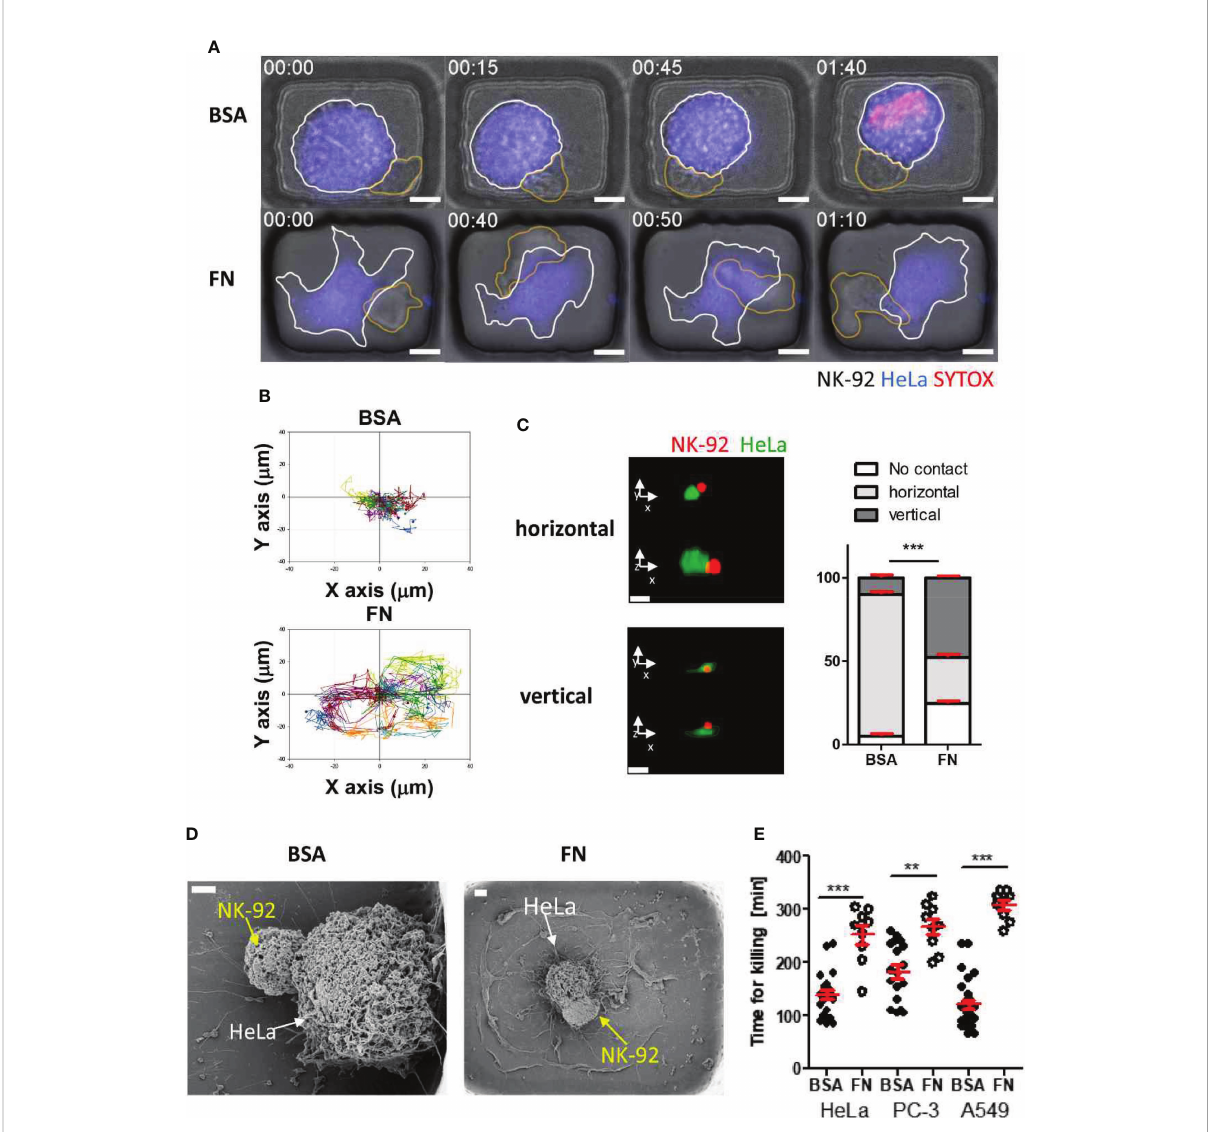
FIGURE 5 Dynamic behaviors and cytotoxicity of NK cells in microwells coated with BSA or FN (A) Representative time-lapse images of NK-HeLa interactions in microwells coated with BSA or FN. Scale bars: 10 m m. (B) Representative trajectories of NK cell centroid. For each case, 15 NK cells were traced over 5 h and plotted with the initial NK-tumor contact points as the origin. (C) Representative confocal images of NK-92 (red) HeLa (green) pairs in microwells and their distributions in BSA- and FN-coated microwells. Scale bars: 15 m m. (D) Representative SEM images of NK-92-HeLa pairs in BSA- and FN-coated microwells. Scale bar: 2 m m. (E) Effects of microwell surface coating on time for killing. Mann- Whitney test was used, ** < 0.01, *** <